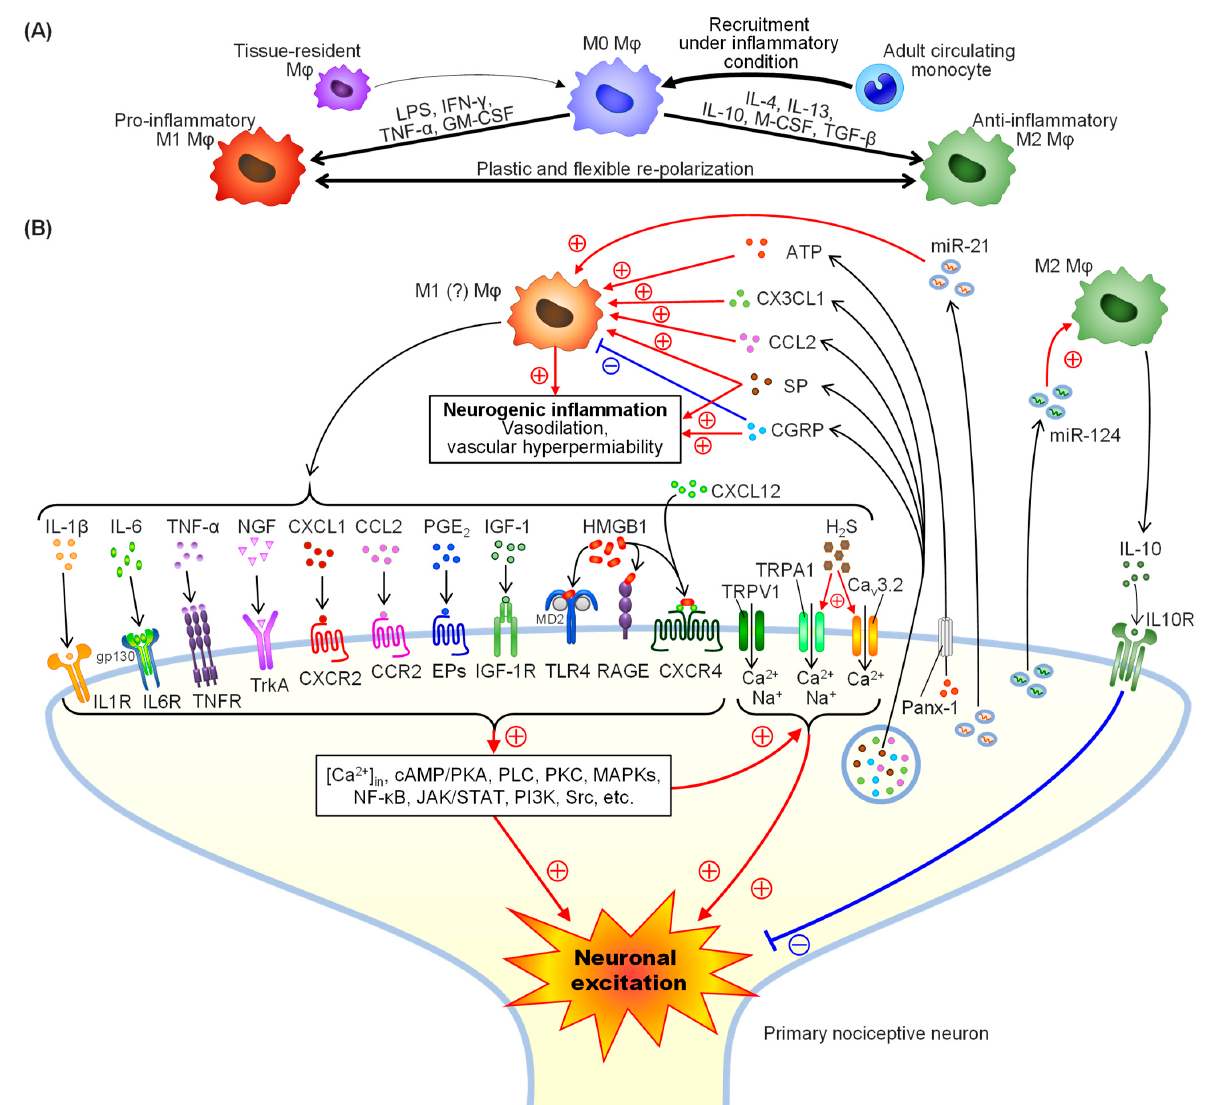
Figure 2. Macrophage (M ϕ ) polarization and messengers essential for a crosstalk between macrophages and primary afferent neuros. ( A ) M0 macrophages derived from tissue-resident macrophages and adult-circulating monocyte-derived infiltrating macrophages are polarized to pro-inflammatory M1 phenotype by lipopolysaccharide (LPS), interferon- γ (IFN- γ ), tumor necrosis factor- α (TNF- α ) and granulocyte-macrophage colony-stimulating factor (GM-CSF), and to anti-inflammatory M2 phenotype by interleukin (IL)-4, IL-10, IL-13, transforming growth factor- β (TGF- β ) and macrophage colony-stimulating factor (M-CSF). ( B ) A number of messengers derived from M1 macrophages and primary sensory neurons participate in